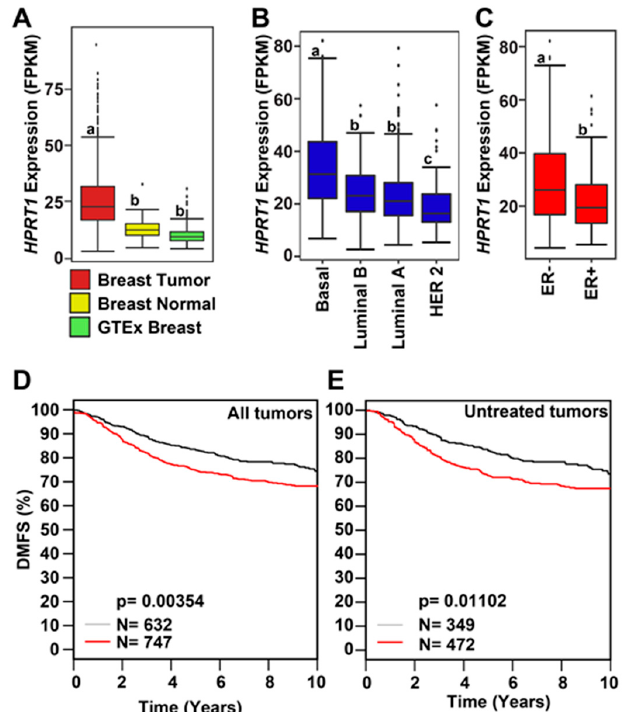
Figure 2. HPRT1 expression in breast cancer. ( A ) Expression of HPRT1 (FPKM—Fragments per Kilobase of transcript per Million mapped reads) comparing data from The Cancer Genome Atlas (TCGA) against normal breast samples from TCGA and Genotype-Tissue Expression (GTEx), respectively. Box plots marked with different letters (a, b) are significantly different from each other ( p < 2.22 × 10 − 16 ; Wilcoxon rank-sum test). ( B ) Expression of HPRT1 (FPKM) comparing different molecular subtypes of breast cancer: basal, luminal B, luminal A, and HER2. Box plots marked with different letters (a, b, c) are significantly different from each other ( p < 2.3 × 10 − 7 and p < 0.041; Wilcoxon rank-sum test). ( C ) HPRT1 expression (FPKM) grouped by estrogen receptor (ER) + and (ER) − subtypes. Box plots marked with different letters (a, b) are significantly different from each other ( p < 0.00018; Wilcoxon rank-sum test). Kaplan–Meier curve showing survival analysis and poor clinical outcome in all ( D ) and untreated ( E ) breast cancer patients in terms of DMFS (distant metastasis-free survival; red line—higher expression; black line—lower expression). The cancer outcome linked gene expression data were accessed and graphed in March 2020, using http://co.bmc.lu.se/gobo/.